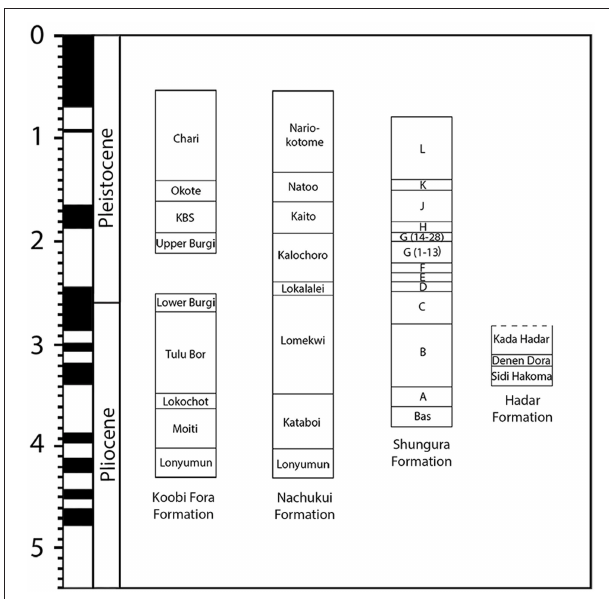
FIGURE 2 | Correlation of the Koobi Fora, Nachukui, Shungura and Hadar Formation with magnetochronostratigraphic and geochronologic time scales. Modified from Werdelin